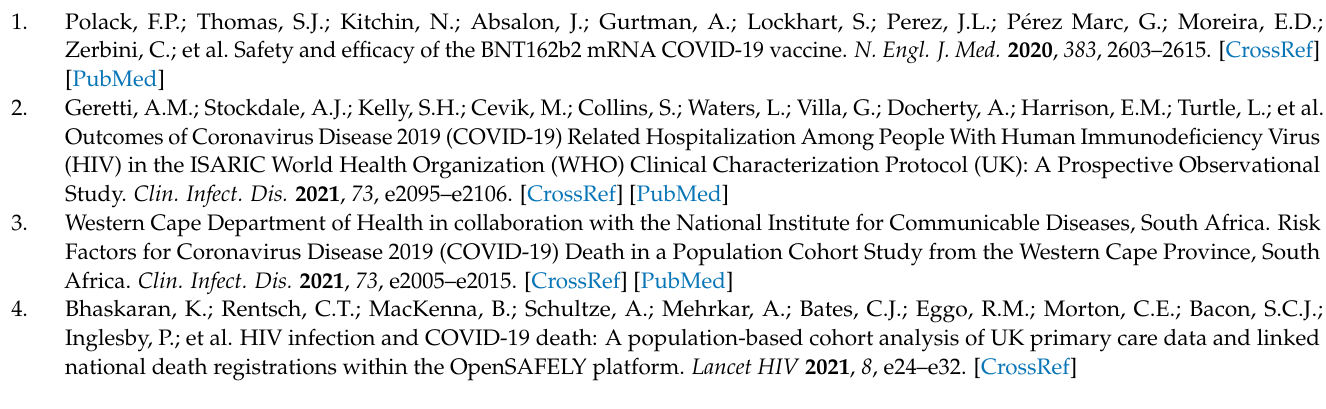
Table S1. Search strategy; Table S2. Risk of bias of all included studies; Table S3. Meta-regression for odds ratio for the seroconversion in COVID-19 vaccinated PLWH with high and low CD4 T cells; Table S4. Certainty of evidence and summary effect estimates assessed by GRADE; File S1. List of excluded